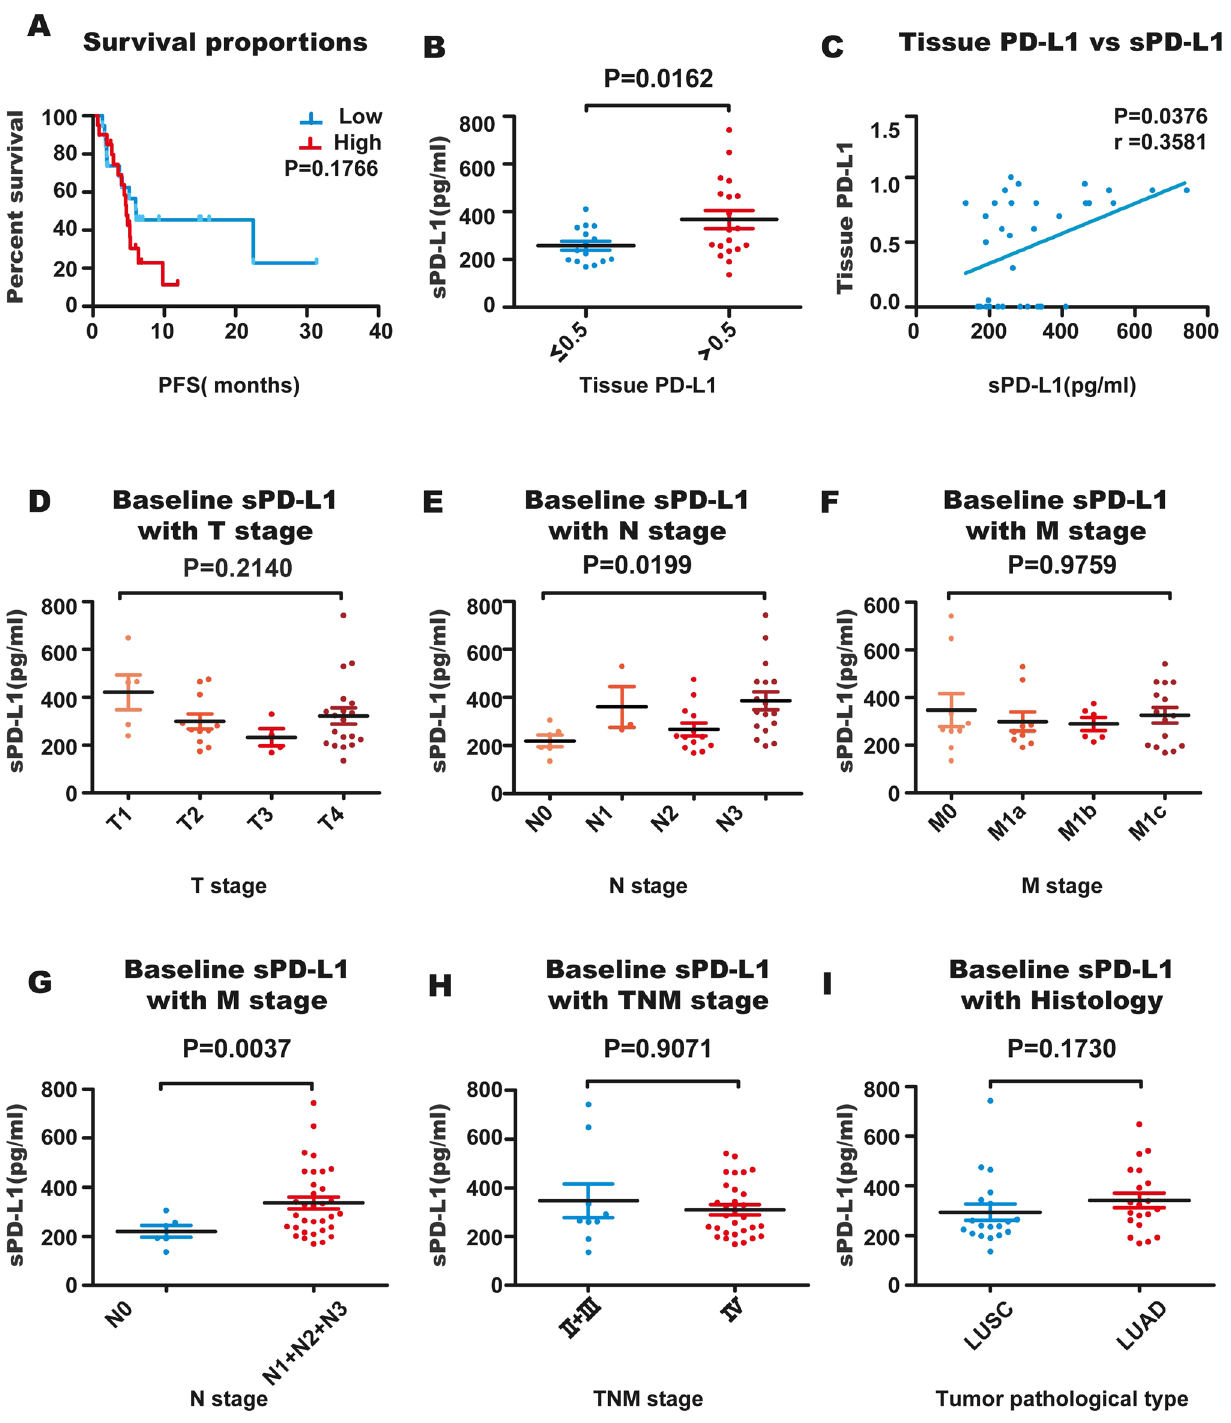
Fig. 2 Correlation between baseline functional sPD-L1 and clinical characteristics. A The difference in PFS between patients with low and high functional sPD-L1 levels was compared (P = 0.1766), and dichotomization was based on the median plasma functional sPD-L1 level. B Baseline functional sPD-L1 was compared between patients with low and high tumor tissue PD-L1 expression (P = 0.0162). C Correlation between tissue PD-L1 and baseline functional sPD-L1 (P = 0.0376, r = 0.3581). D , E , F , Patient baseline functional sPD-L1 levels were com- pared among different T, N, and M stages, and there was a significant difference between the four subsets in N staging (P = 0.0199). G Com- parison of baseline functional sPD-L1 between patients with or without lymph node metastasis (N0 vs. N1 + N2 + N3, P = 0.0037). H Compari- son of baseline functional sPD-L1 between patients at different TNM stages (II + III vs. stage IV, P = 0.9071). Comparison of baseline functional sPD-L1 in patients with different tissue types (squamous cell carcinoma vs. adenocarcinoma, P =